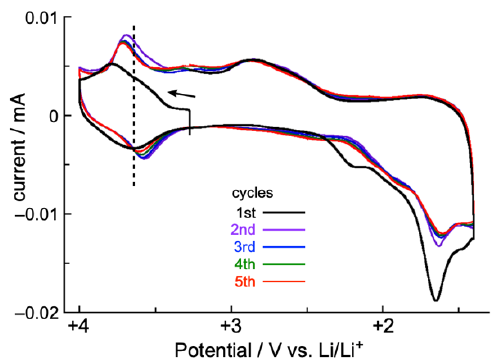
Figure 6. Solid-state cyclic voltammogram (CV) of zinc(II) complex 5 (V vs. Li/Li + ). Coin-type cell with a cathode composed of 10:10:80 (wt%) of 5 , poly vinylidene difluoride (PVDF) and acetylene black, (AB), respectively; a Li metal anode; and an electrolyte solution of 1 M LiPF 6 in 3:7 v/v of ethylene carbonate/ diethyl carbonate (EC/DEC). The scan rate was 0.1 mV/s.